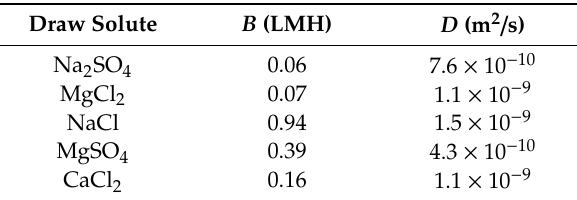
Table 2. B and D of the draw